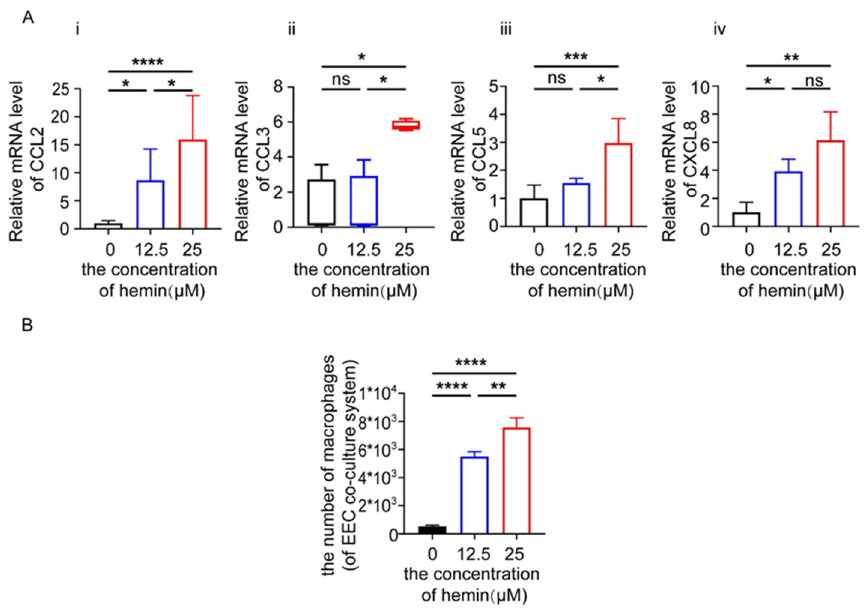
Figure 7. Heme increases the expression of chemokines in EECs and recruits macrophages. ( A ) Rela- tive mRNA expression of CCL2 , CCL3 , CCL5 , CXCL8 in EECs treated with Hemin at the concentration of 12.5 µ M and 25 µ M for 48 h. ( B ) We illustrate the recruitment of macrophages co-cultured with EECs, which were untreated or treated with Hemin at the concentration of 12.5 µ M or 25 µ M for 48 h; we counted the number of recruited macrophages. Data are presented as the mean ± standard error of the mean ( A.i , A.iii , A.iv , B ), or the median and the interquartile range ( A.ii ). Statistical significance (one-way ANOVA with a Bonferroni multiple-comparisons test ( A.i , A.iii , A.iv , B ) or Kruskal–Wallis test with Dunn’s multiple-comparisons test ( A.ii )): * p < 0.05, ** p < 0.01, *** p < 0.001, **** p <